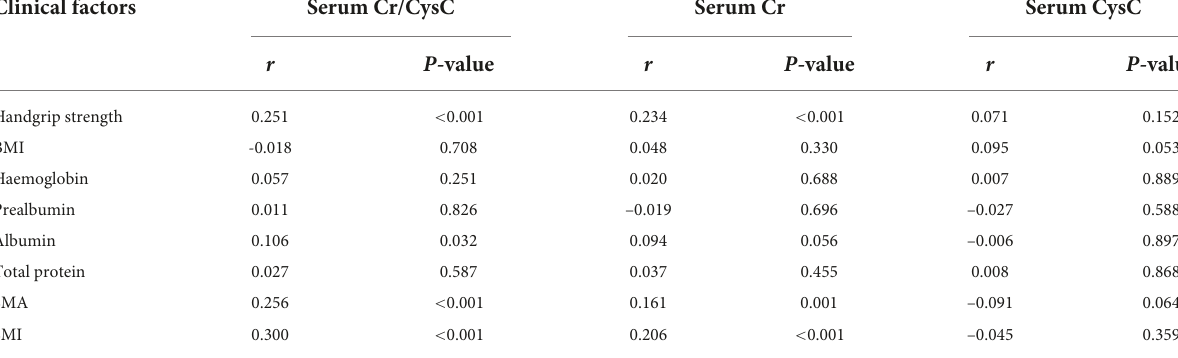
TABLE 3 Correlation coefficients between biomarkers and clinical